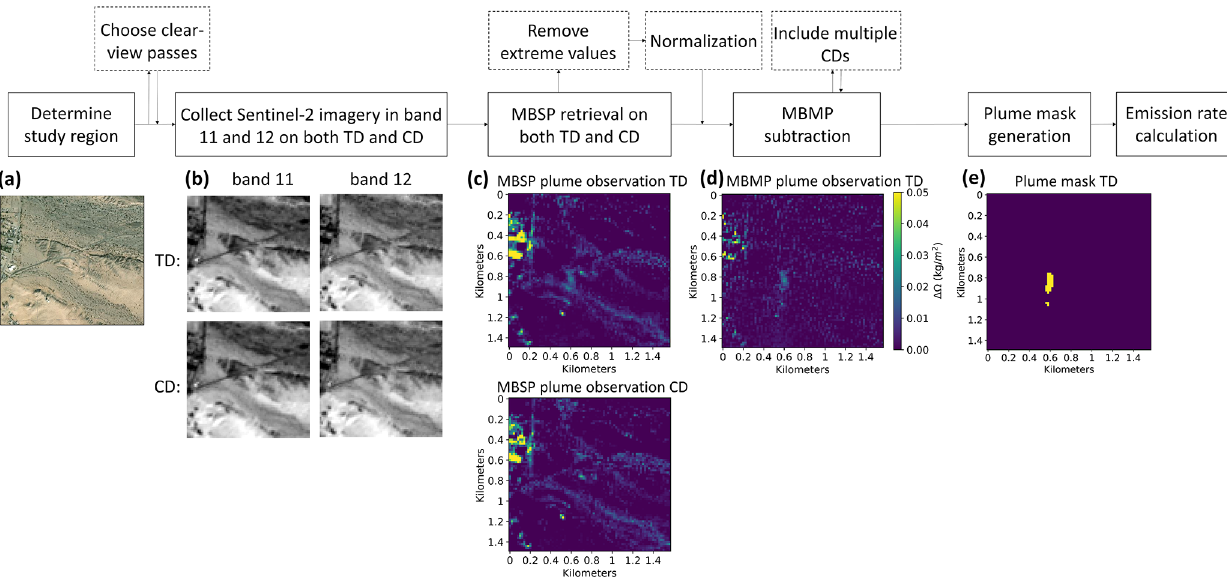
Figure 1. Basic algorithm workflow. Solid boxes are specific steps of the multi-band–multi-pass (MBMP) retrieval. Dashed boxes are new modifications added in this study. (a) Study region. (b) Sentinel-2 imagery in band 11 and 12 on both target date (TD, top row) and comparison date (CD, bottom row), with pixel value as reflectance. (c) MBSP retrieval on both TD (top row) and CD (bottom row) with pixel value as methane column concentration (kgm − 2 ). (d) MBMP retrieval on TD, i.e., the result of subtracting the MBSP retrieval on TD by the MBSP retrieval on CD. (e) Boolean plume mask generated from MBMP retrieval by selecting methane columns above some percentage threshold for the scene and smoothing with a median filter (window size 3 × 3) and a Gaussian filter (window size 3 × 3). The basemap of (a) is the ArcGIS Online World Imagery Basemap. The sources for the data used are as follows: Esri, DigitalGlobe, GeoEye, i-cubed, USDA FSA, USGS, AEX, Getmapping, Aerogrid, IGN, IGP, swisstopo, and the GIS User